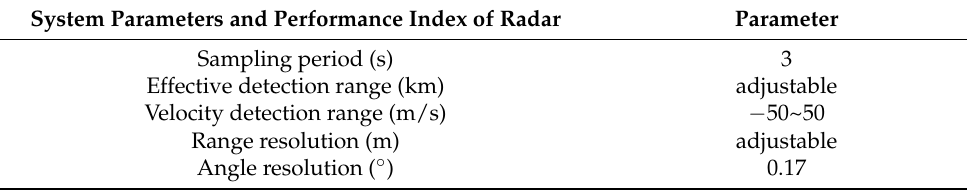
Table 1. Partial parameters and performance indices of sea surface navigation